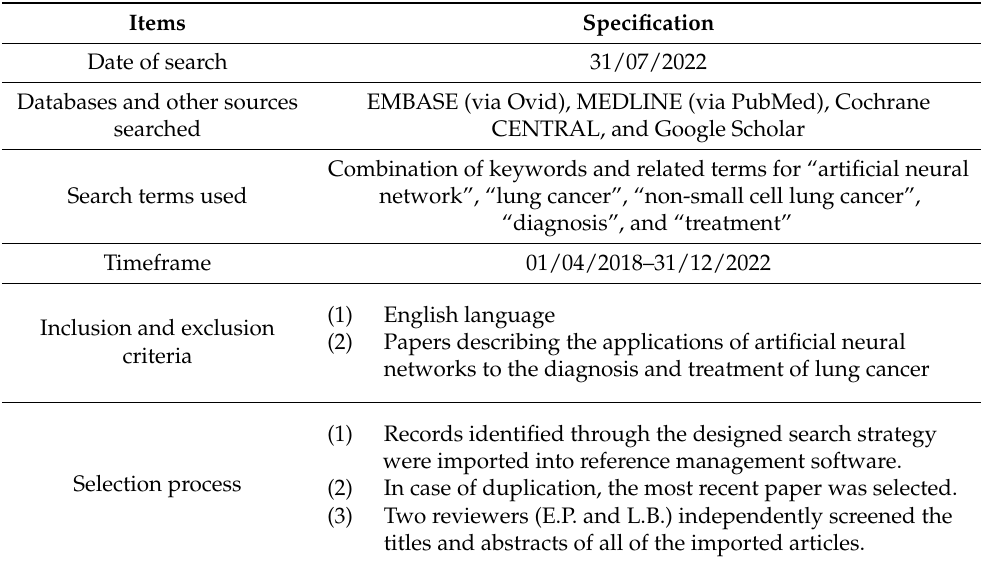
Table 1. Search strategy summary of the present narrative